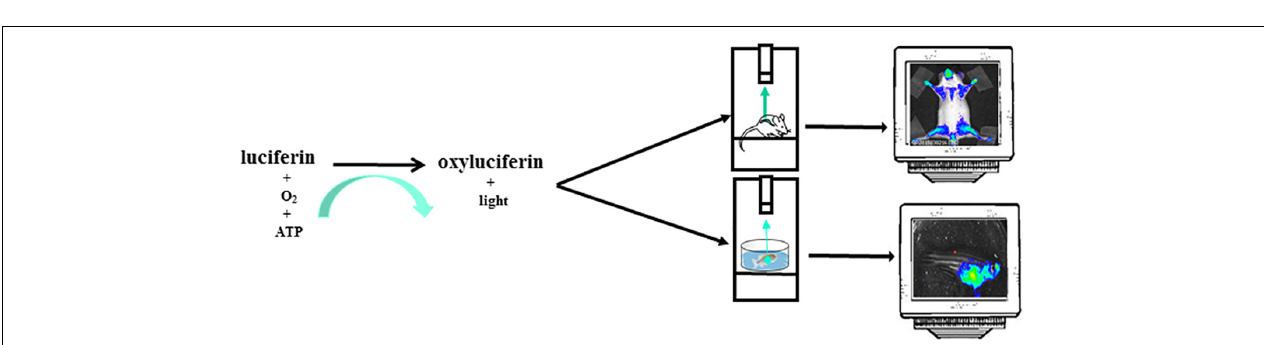
FIGURE 2 | The instrument used for luminescence is composed of an ultra-sensitive cooled CCD camera linked to a dark box. In the dark box is present a shelf heated at 37 ◦ C where the mice, or the petri dish with zebrafishes, are positioned. The mice are euthanized trough a system delivering isoflurane or by i.p. injection of sedatives. For zebrafish imaging sessions the sedative is dissolved in the water. The CCD camera detects light coming from mice or zebrafishes. The images are collected and analyzed by a dedicated software. The mice image is referred to Mito-Luc model described in the text (Goeman et al., 2012). The zebrafish image represents a not already published bioluminescent model of proliferation (GP personal